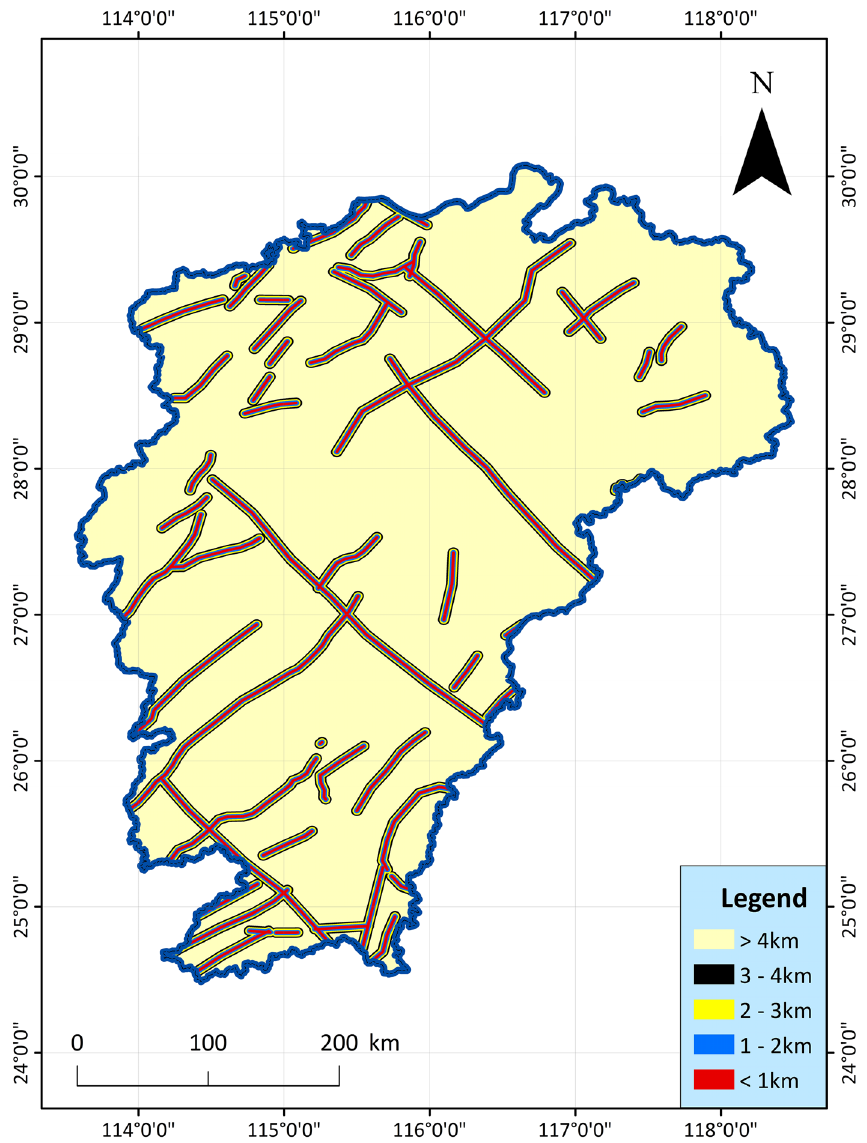
Figure 7. Spatial distribution map of active faults and their distances from active faults in Jiangxi Province 61